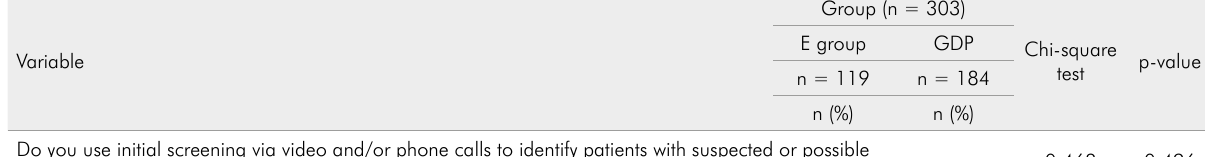
Group (n = 303) p-valueE group GDP Chi-square test n = 119 n = 184 n (%) n (%)